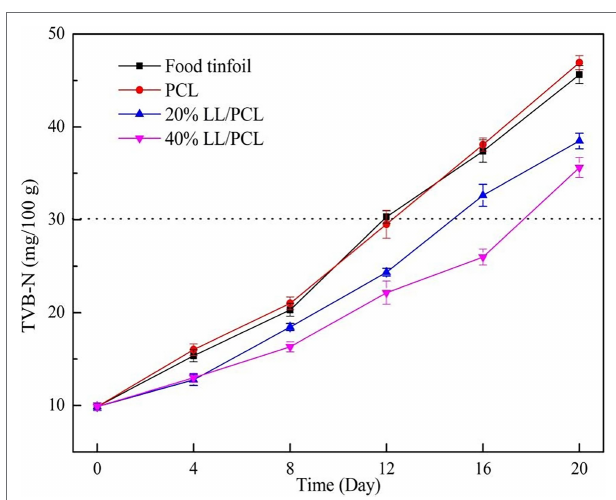
FIGURE 8 | Changes in TVB-N of